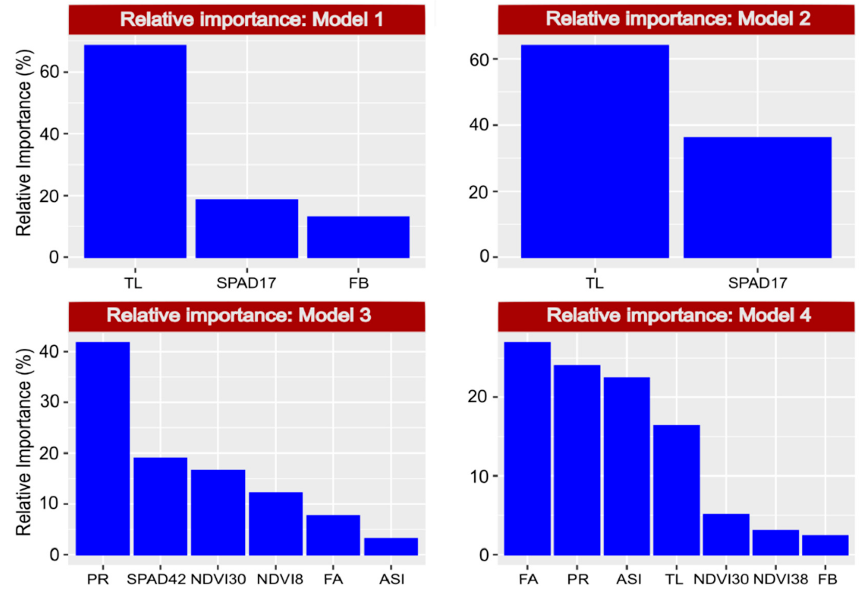
Figure 7. Relative importance of previously selected predictors on the basis of the dependent variable. Model 1: grain yield (GY) under water stress (WS) = TL (tassel length) + SPAD17 (SPAD index evaluated 17 days after anthesis) + FB (leaf rolling). Model 2: GY under well-watered conditions (WW) = TL + SPAD17. Model 3: popping expansion (PE) under WS = NDVI30 (normalized difference vegetation index evaluated 30 days after anthesis) + PR (prolificacy) + SPAD42 (evaluated 42 days after anthesis) + ASI (anthesis-silking interval) + FA (leaf angle) + NDVI8 (evaluated 8 days after anthesis). Model 4: PE under WW = NDVI38 (evaluated 38 days after anthesis) + ASI + FB + TL + FA + PR + NDVI30.